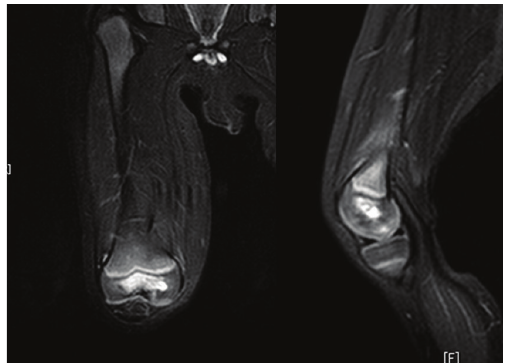
Figure 2: STIR sequences on MRI two weeks after treatment show that bone marrow abnormality and soft tissue edema of the femur have improved. Note the high intensity area in the epiphysis, especially in the medial epiphyseal nucleus.